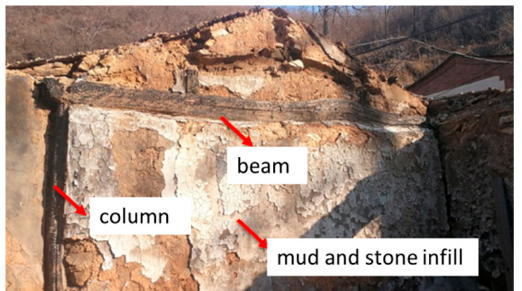
Figure 2. A timber frame with thick mud and stone infill.